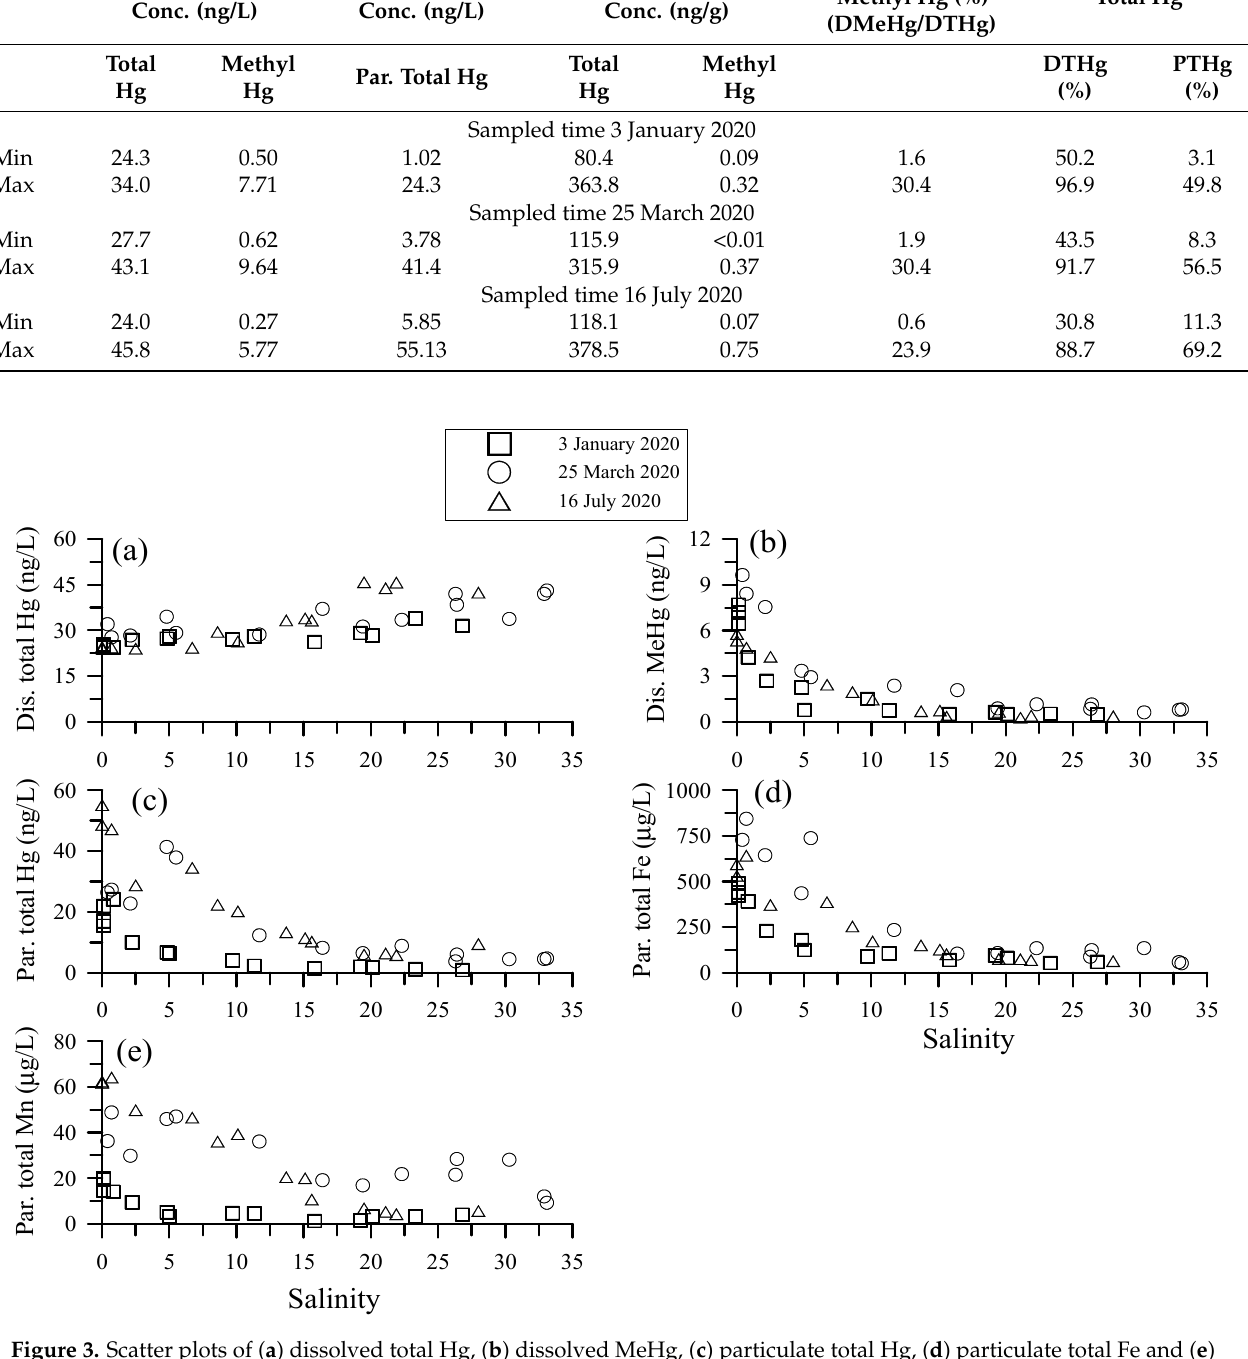
Figure 3. Scatter plots of ( a ) dissolved total Hg, ( b ) dissolved MeHg, ( c ) particulate total Hg, ( d ) particulate total Fe and ( e ) particulate total Mn concentrations against salinity in the Danshuei River Estuary, northern Taiwan. Table 1. Concentration ranges for different species of the analyzed Hg, the percentage of methyl Hg to total Hg in water and sediment samples, and the percentages of dissolved total Hg and particulate total Hg to total Hg in waters in the Danshuei River Estuary, northern Taiwan.